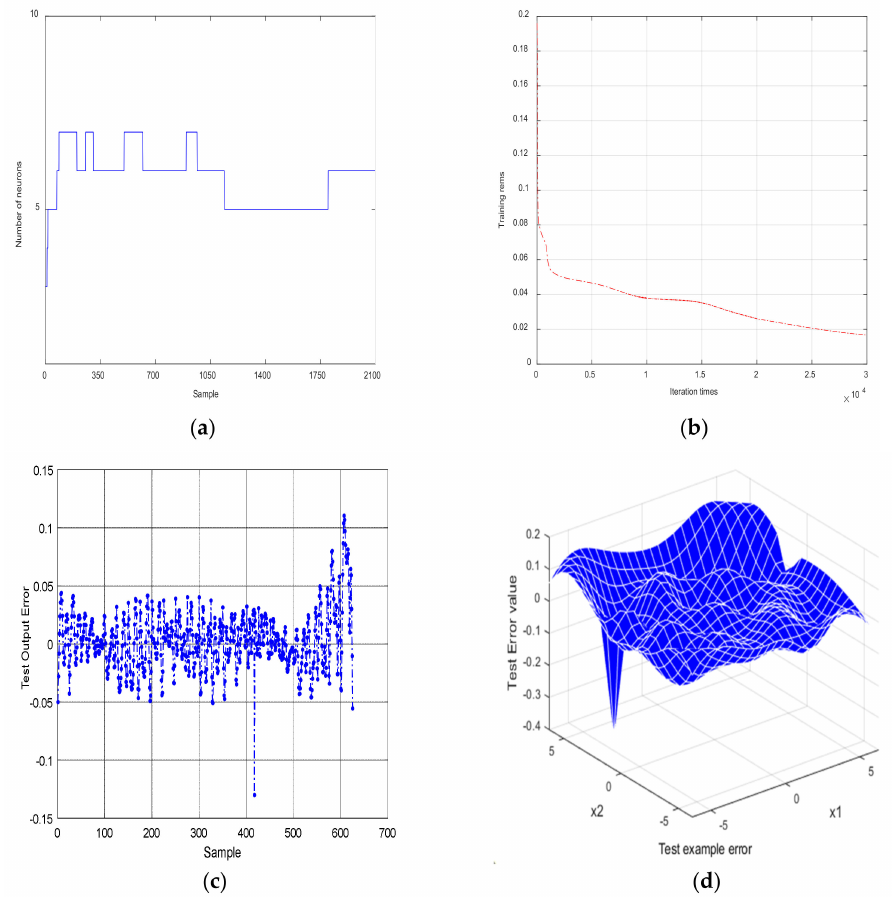
Figure 2. Approximation results of the RBFNN-GP in example A. ( a ) Number of neurons; ( b ) The training RMSE value in example A; ( c ) Test examples output error in example A; ( d ) Test examples output error